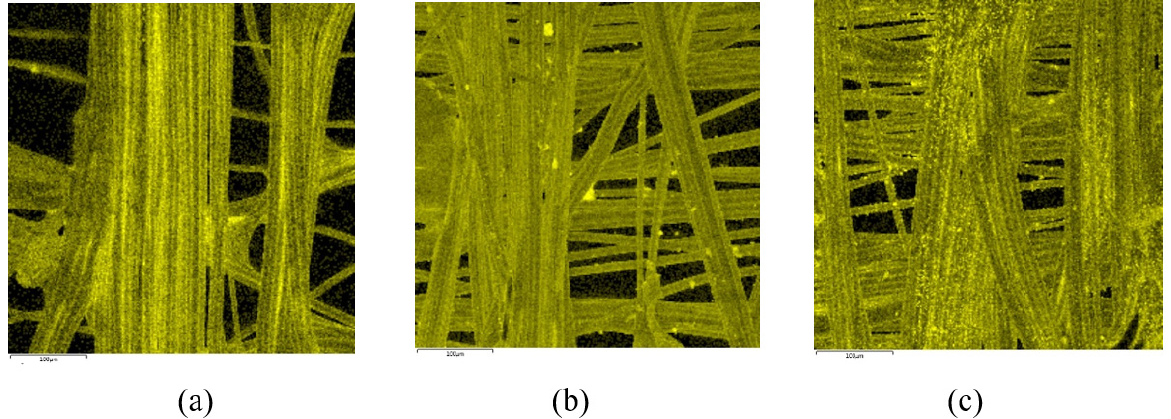
Figure 5. X ‐ ray spectroscopy–EDX analysis of ( a ) MEFTEX 10 ( b ) MEFTEX 20 ( c ) MEFTEX 30 element Cu distribution. Table 2. EDX analysis of MEFTEX surface.